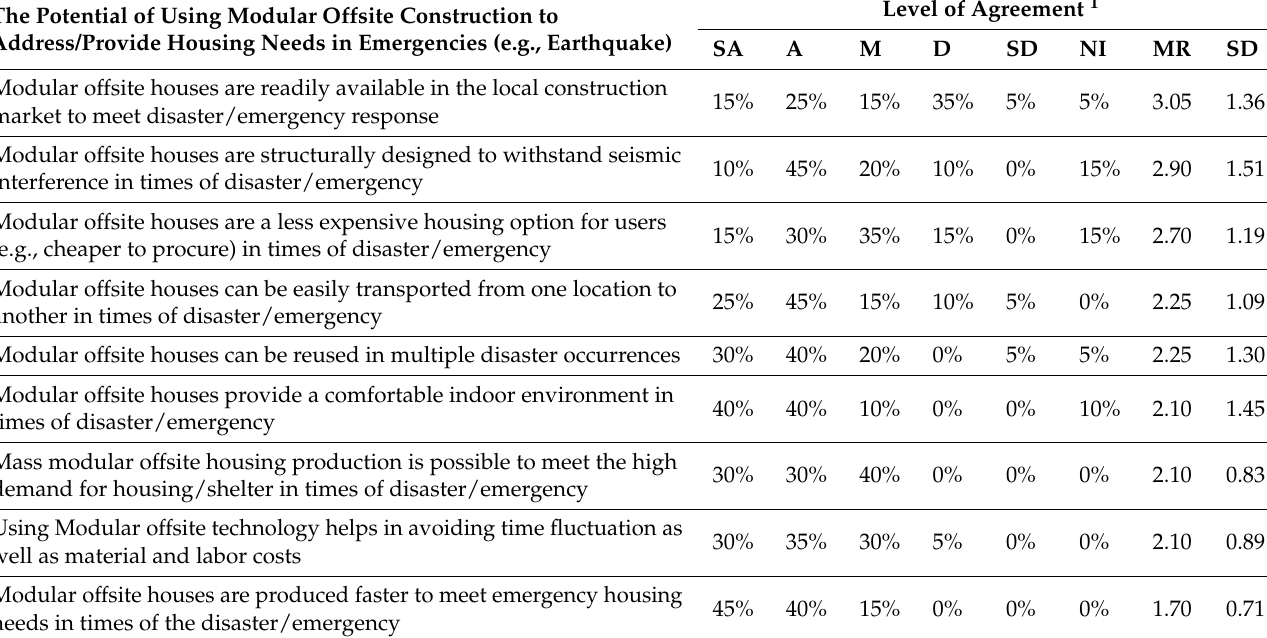
Table 4. The potential of using modular offsite construction to address/provide housing needs in emergencies (e.g.,